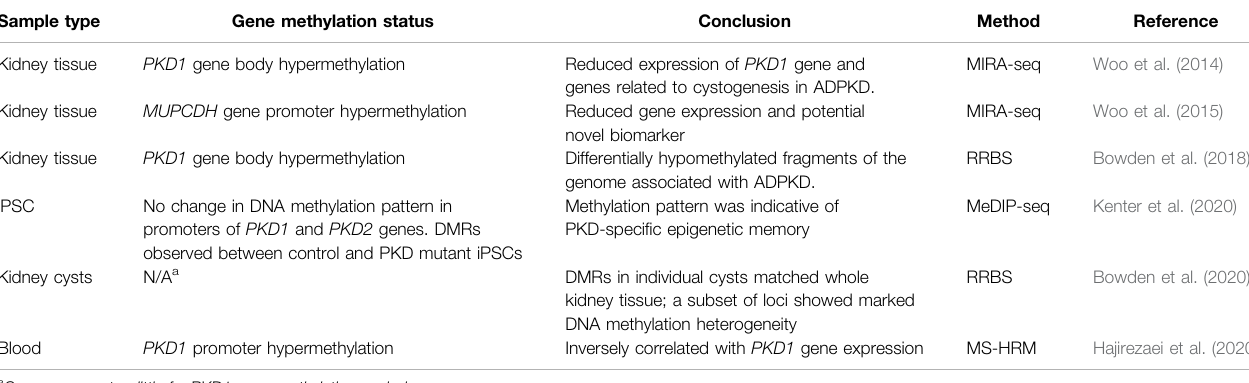
TABLE 1 | Summary of DNA methylation studies in